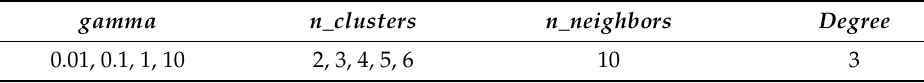
Table 2. Spectral clustering parameters setting in OCMF process.